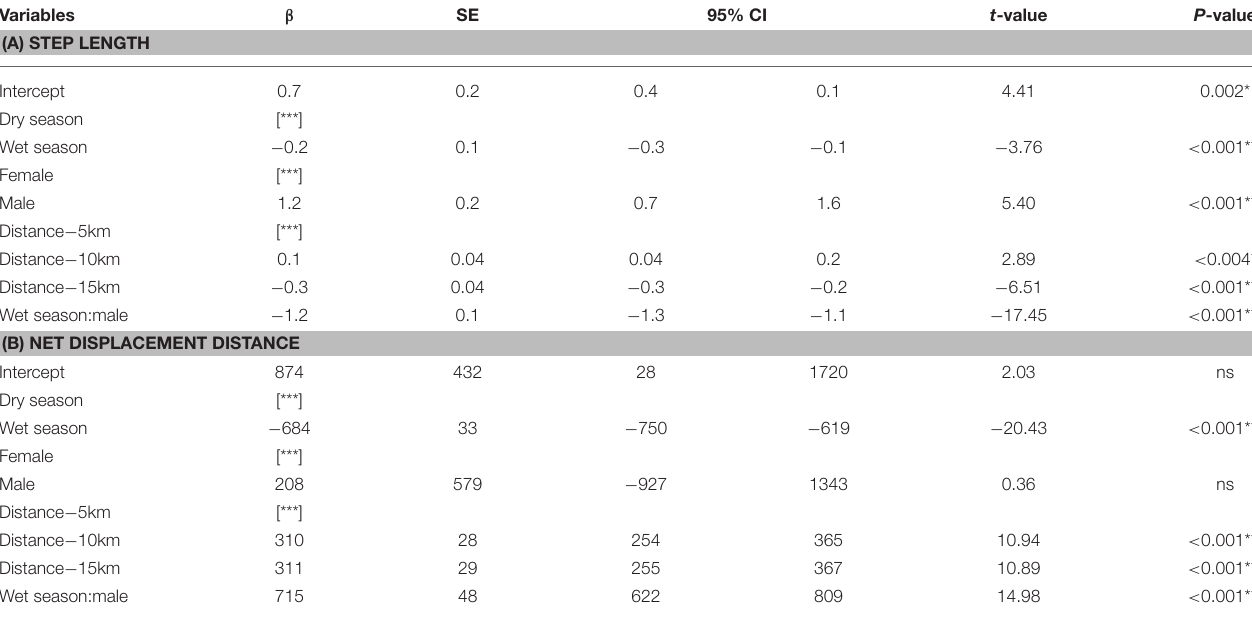
TABLE 1 | Results of the LMM models for step length (A) and net displacement distances (B) . Variables β